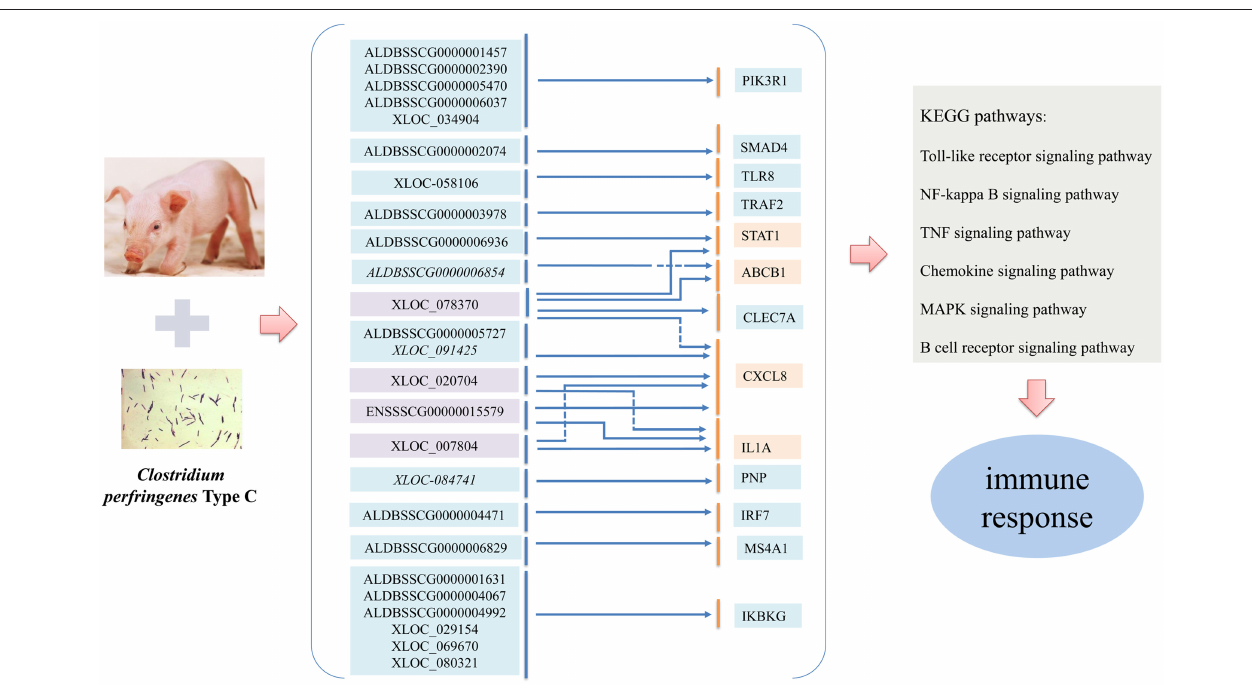
FIGURE 7 | Overview of the regulatory relationship between the differentially expressed lncRNAs and their immune-related target genes involved in CPID. Italics and non-italics fonts of lncRNA indicate the cis and trans regulatory functions of lncRNAs,